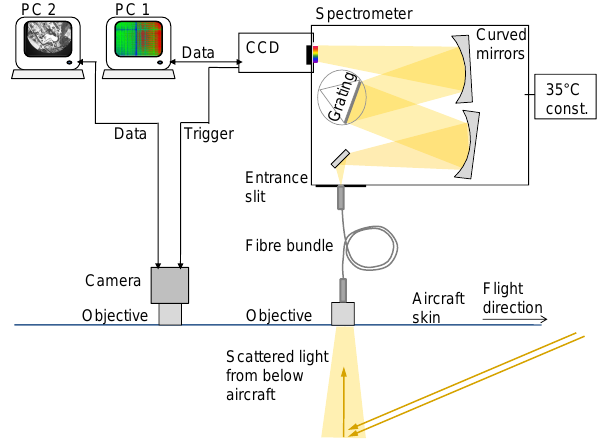
Figure 1. Sketch of the imaging DOAS instrument set-up with two nadir viewing wide-angle objectives, one objective directing the backscattered radiation via a sorted glass fibre bundle into an imag- ing spectrometer where the radiation is recorded by a frame-transfer CCD, and one objective collecting the incoming radiation for direct scene photography and additional pointing